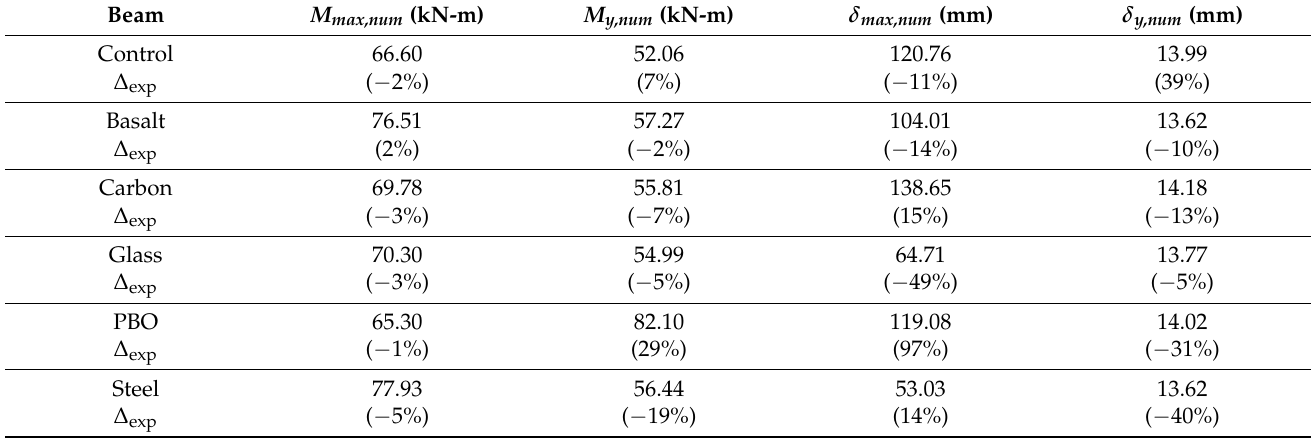
Table 7. Numerical simulation